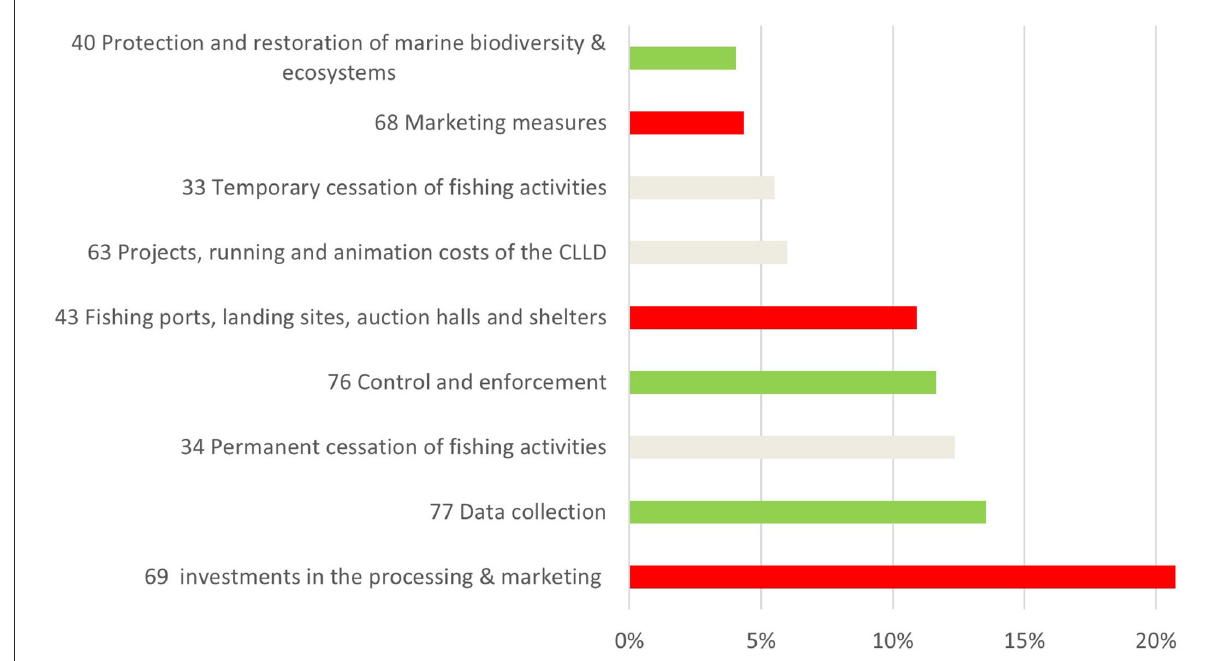
FIGURE1 Top 10 EMMF measures in six Mediterranean countries based on percentage of total financial allocation. Elaboration on data from the operations lists of Croatia, Mediterranean France, Greece, Italy, Malta, and Mediterranean Spain until December 2020 (red bar = capacity enhancing, green bar = beneficial; gray bar = ambiguous).